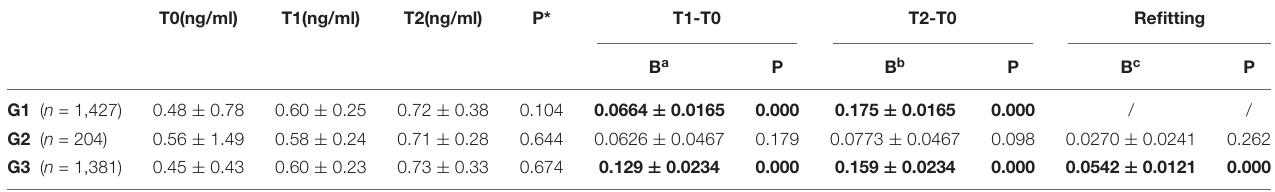
FIGURE 2 | The changes of the testosterone (T) levels of Groups 1–3. Group 1: no clinical pregnancy; Group 2: clinical pregnancy and no live birth; and Group 3: live birth. T0: T levels at baseline, T1: T levels on the trigger day, and T2: T levels on the day after the trigger day. TABLE 2 | Repeated measurement analysis of androgen levels at three time points with different IVF outcomes using linear mixed effect models.